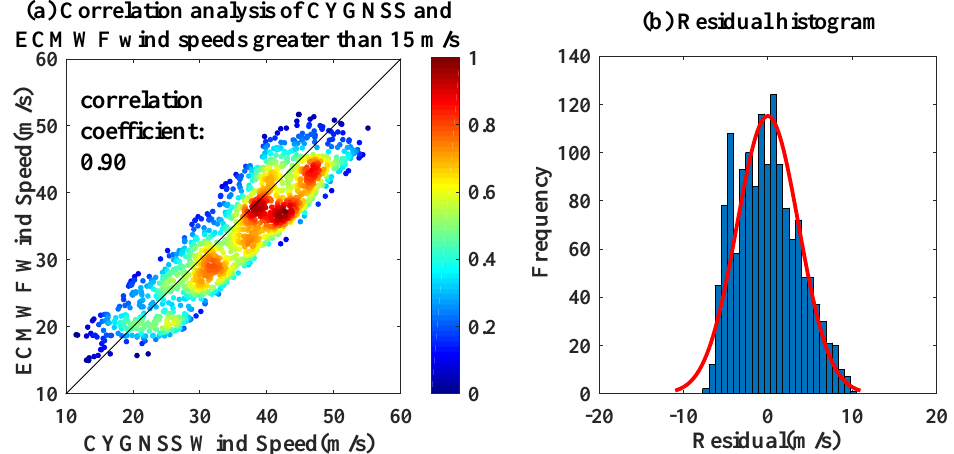
Figure 7. Scatter density plot and residual distribution of CYGNSS and ECMWF wind speeds greater than 15 m / s. ( a ) Scatter plot of CYGNSS and ECMWF winds greater than 15 m / s; ( b ) CYGNSS and ECMWF wind speed residual distribution histogram. The colors bar (from cool to warm) represents the change of scatter density from small to large values in a given range.